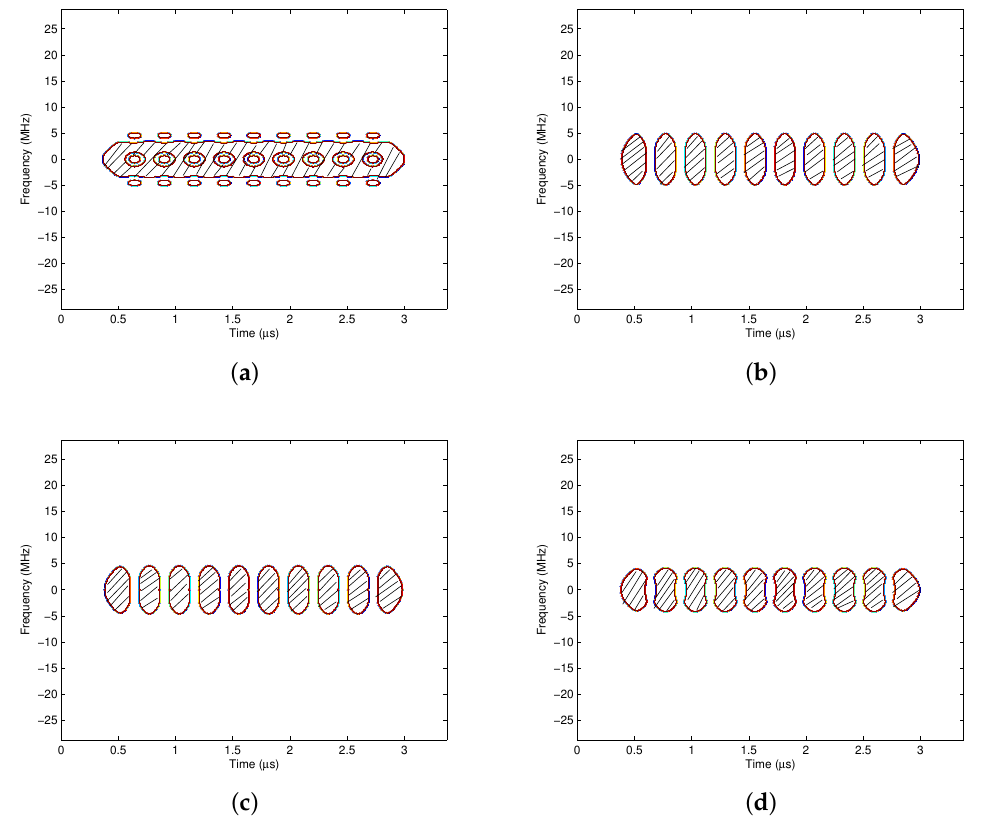
Figure 12. The pass regions with different analysis windows. ( a ) The pass region with the rectangular window; ( b ) The pass region with the Gaussian window; ( c ) The pass region with the Blackman window; ( d ) The pass region with the Hanning window.